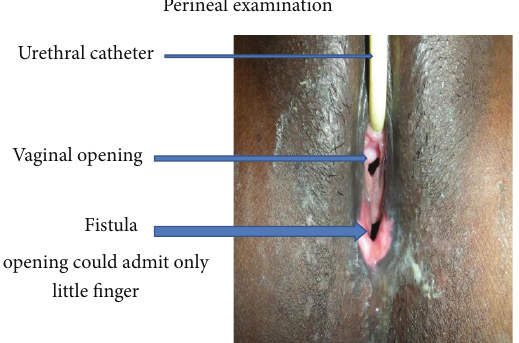
Figure 3: Line of incision depicted around the anorectum.